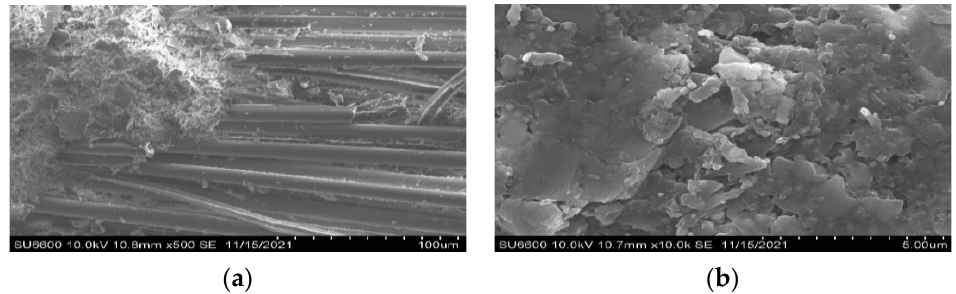
Figure 4. SEM images for NE (control) at 10 kV with magnifications ( a ) 500 ( b ) 10000.